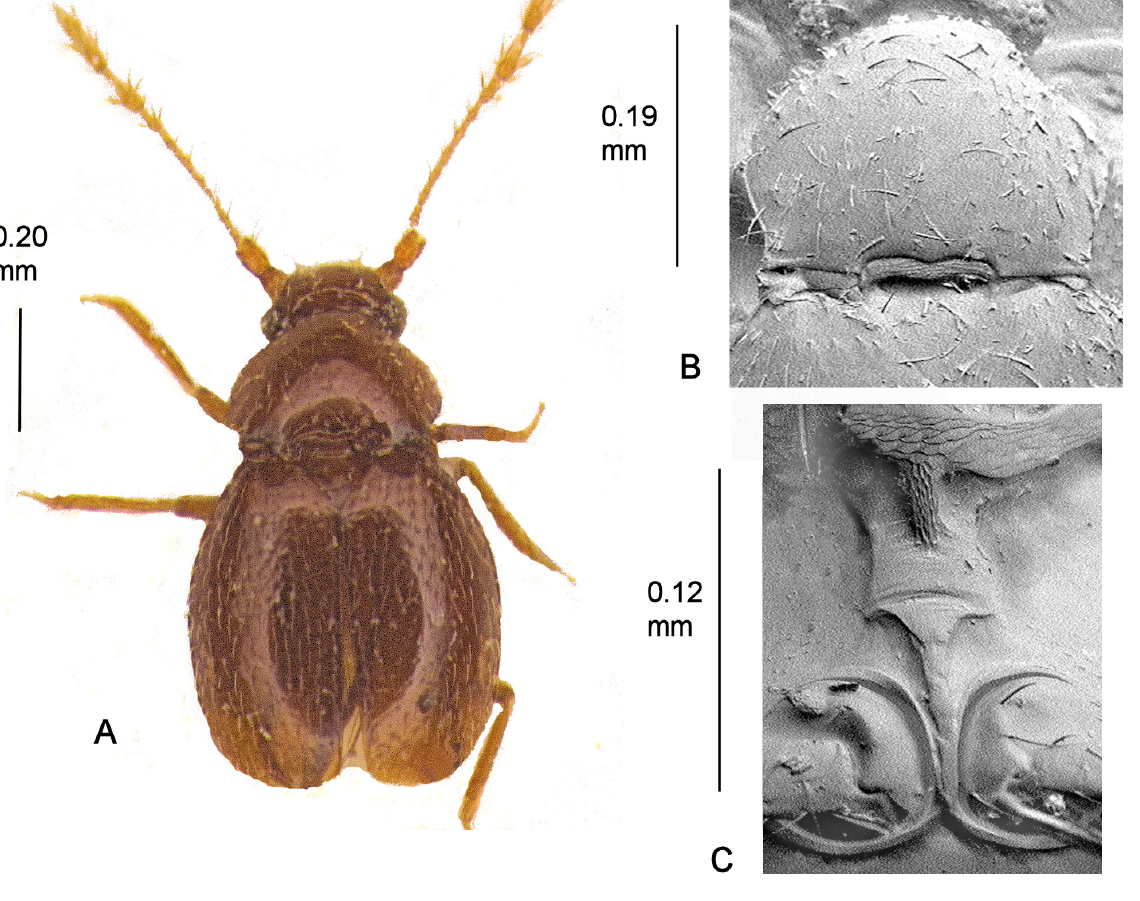
Fig. 67 . Cissidium eciton sp. nov. A . Habitus. B . Pronotum, × 305. C . Mesoventrite showing median process of collar, mid-keel and keel,